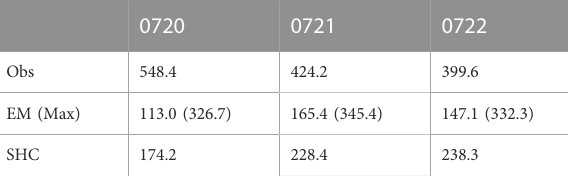
TABLE 6 Maximum precipitation amounts (mm) predicted by the different methods and obtained via observation in subplot (see Figure